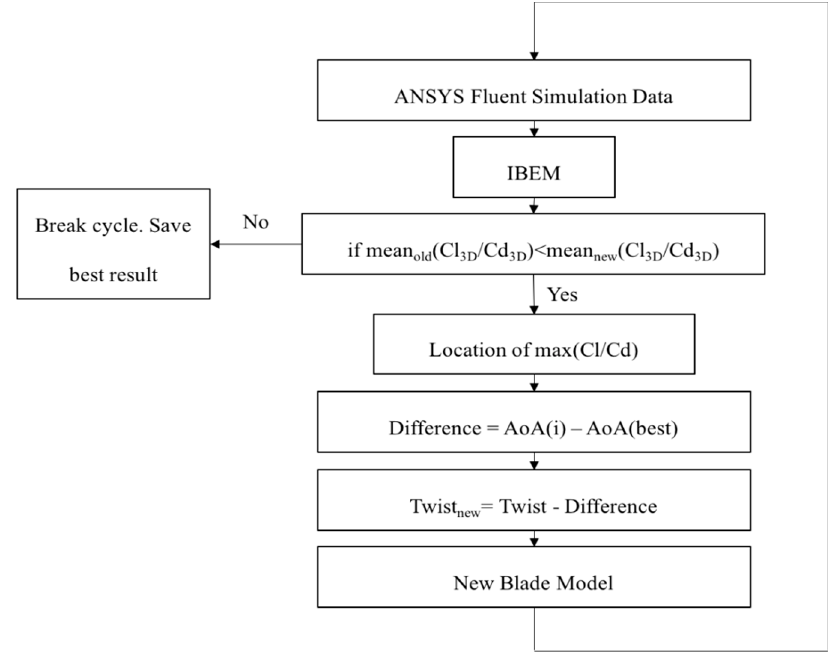
Figure 4. Optimization scheme using IBEM method.